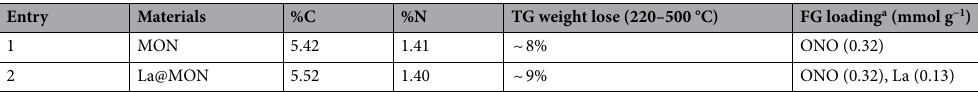
Table 2. Estimation of functional group loading based on the elemental analysis and TG analyses. a Loading of functional groups (lanthanum and dipicolinic carboxamide, ONO) calculated by ICP-MS, TGA, or elemental analysis